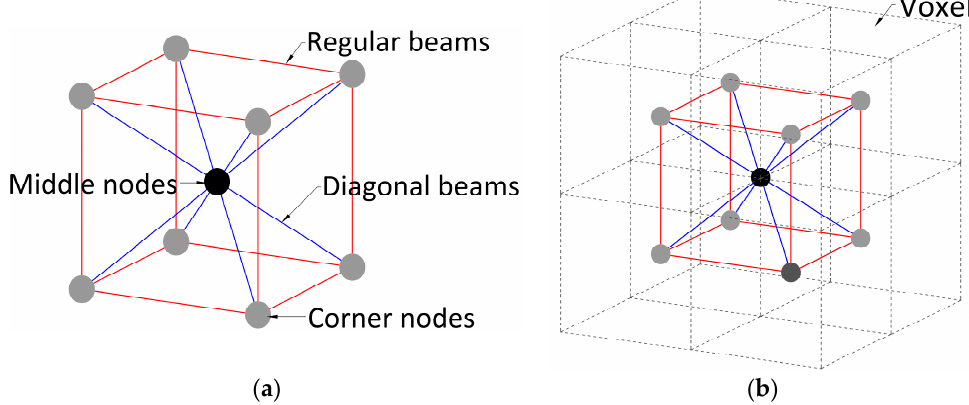
Figure 5. ( a ) Construction of the lattice unit cell based on truncated octahedral; ( b ) positioning of the lattice unit cell on the discretised Representative Elementary Volume (REV) voxels.